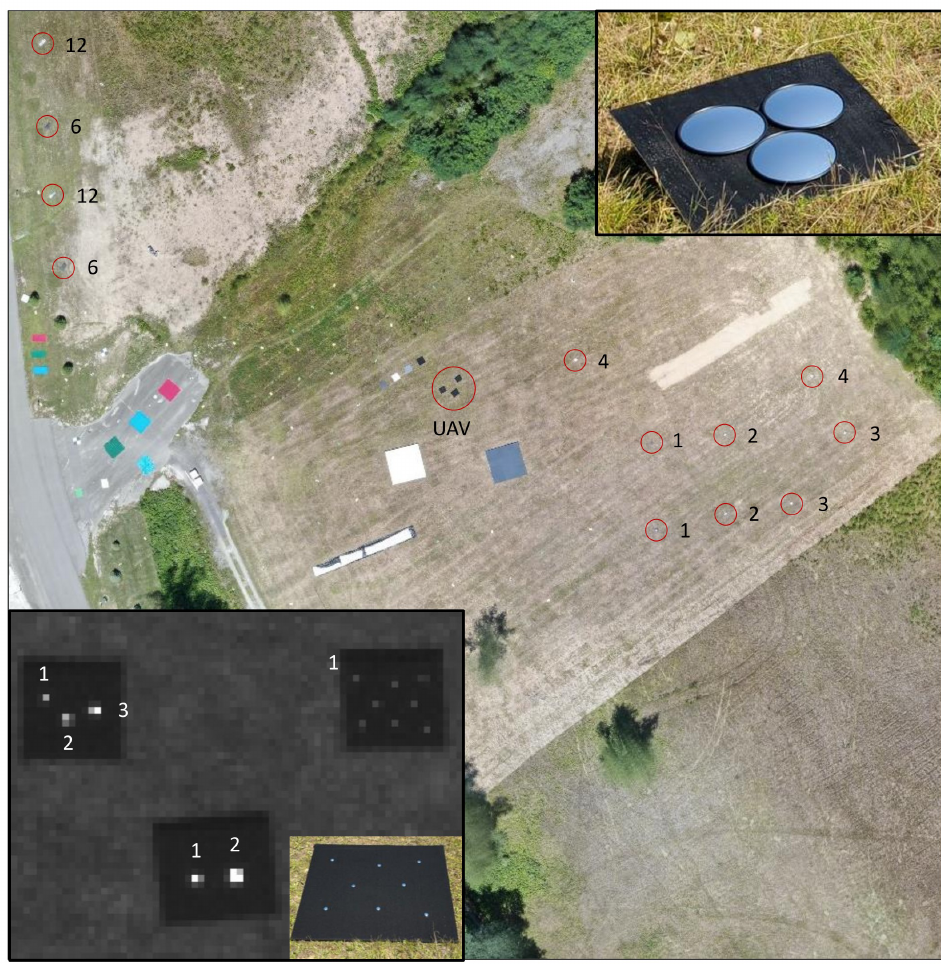
Figure 2. Primary target area during the G-SCALE. SPARC mirror targets for airborne and satellite assets (top inset, 0.22 m diam., 0.38 m RoC) are circled and labeled with the number of individual mirrors deployed (1–12) for that target, with additional arrays of 6 and 12 mirrors positioned North of the main area. A separate type of SPARC target was dedicated to the UAV sensors (bottom inset, left/right: 0.025 m diam., 0.05 m RoC; bottom: 0.05 m diam, 0.10 m RoC). Greyscale and colored diffuse reflectance targets are also